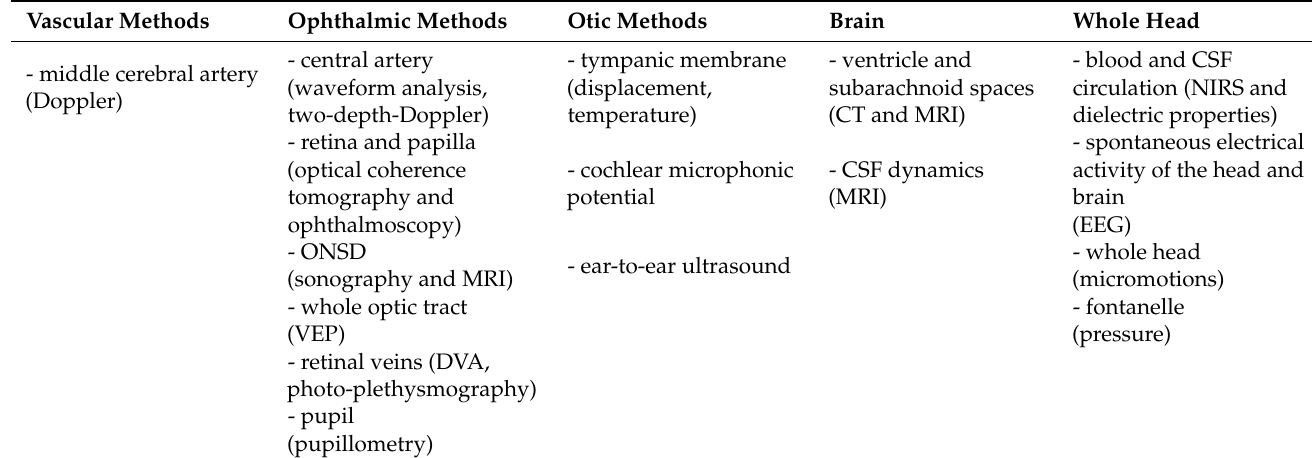
Table 1. Anatomical key structures and methods (in brackets) for measurements.